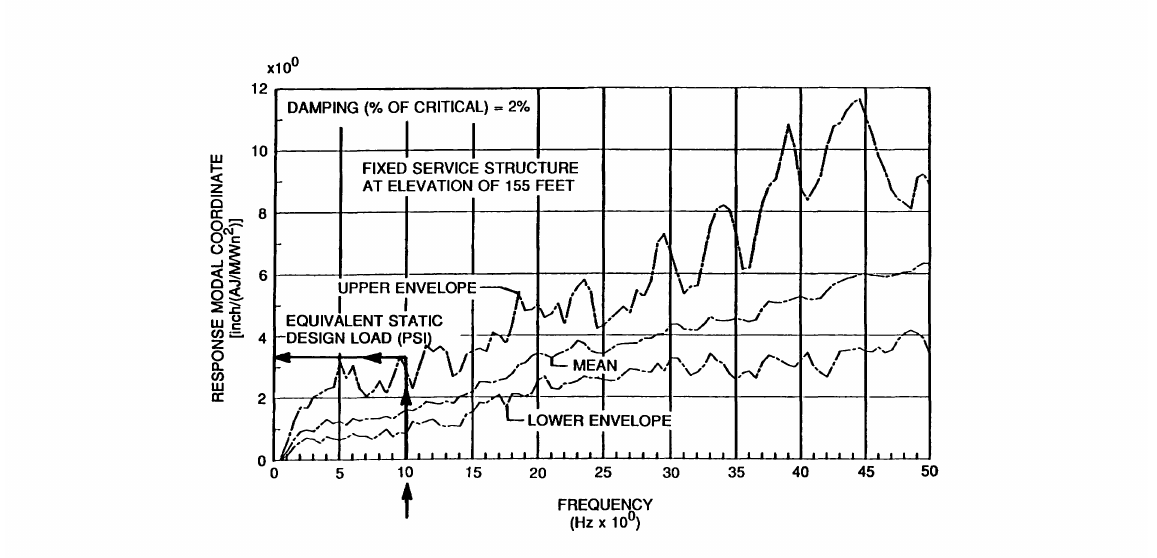
FIGURE 7 Liftoff pressure response spectrum to rocket